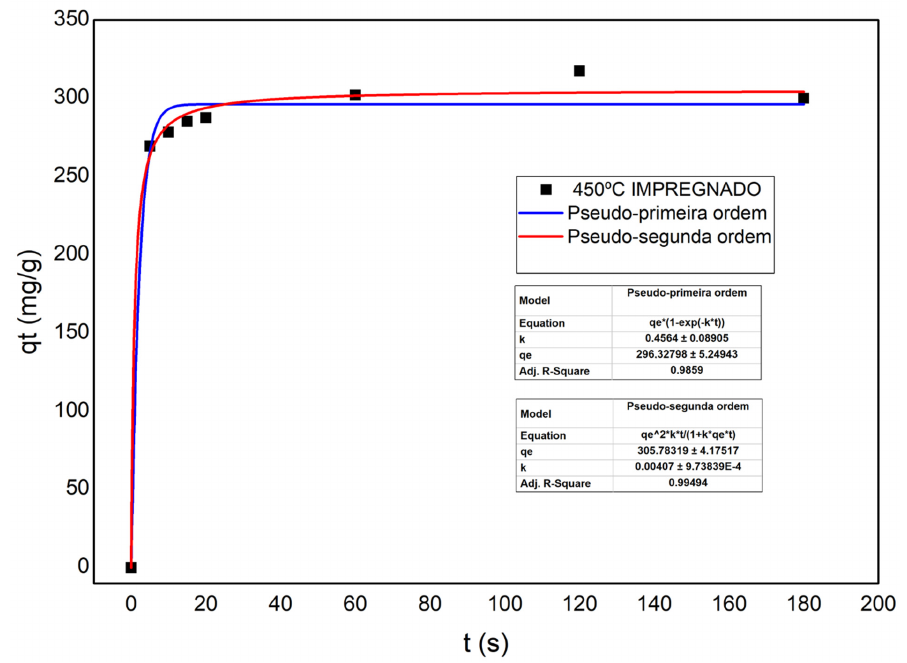
Figure 13. Pseudo-first-order and pseudo-second-order models for the adsorption experiment of impregnated biochar obtained at 450 °C. Table 8. Parameters of pseudo-first-order and pseudo-second-order kinetic models for biochar im- pregnated.